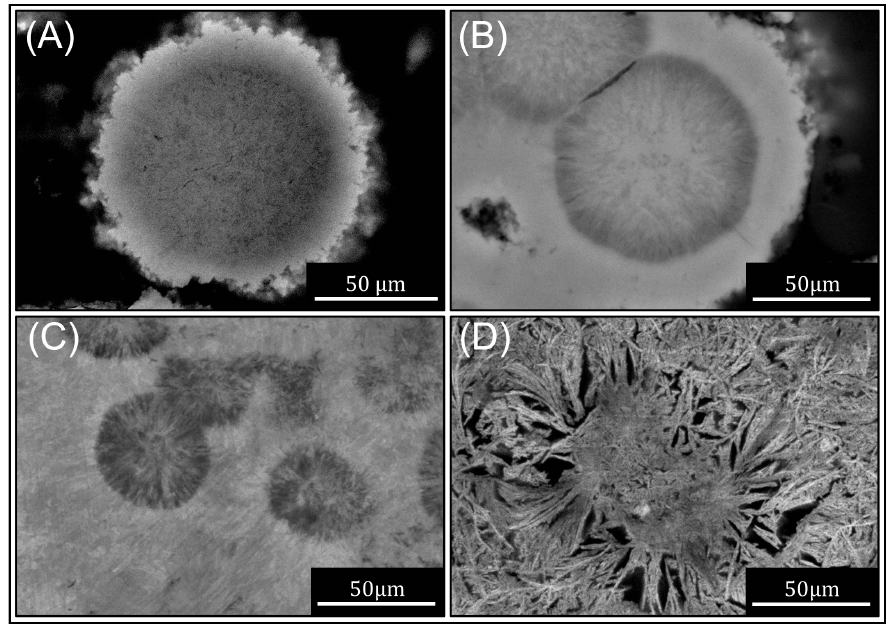
Figure 5. SEM micrograph of nitrided Al powder that has been mounted and polished. Temperatures ranging from 500 to 550 °C: 6 h at ( A ) 500 °C, ( B ) 510 °C, ( C ) 530 °C and ( D ) 550